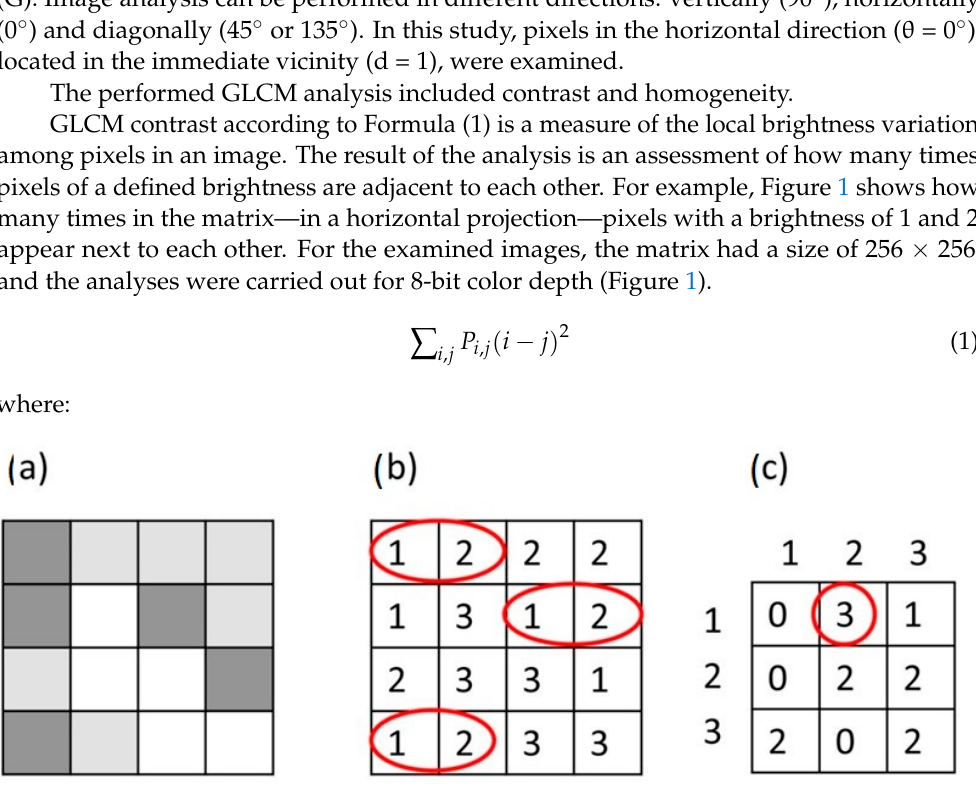
Figure 1. Scheme of the GLCM matrix: ( a ) a fragment showing adjacent pixels; ( b ) the complex pixel configuration; ( c ) the number of pixel pairs in this configuration.